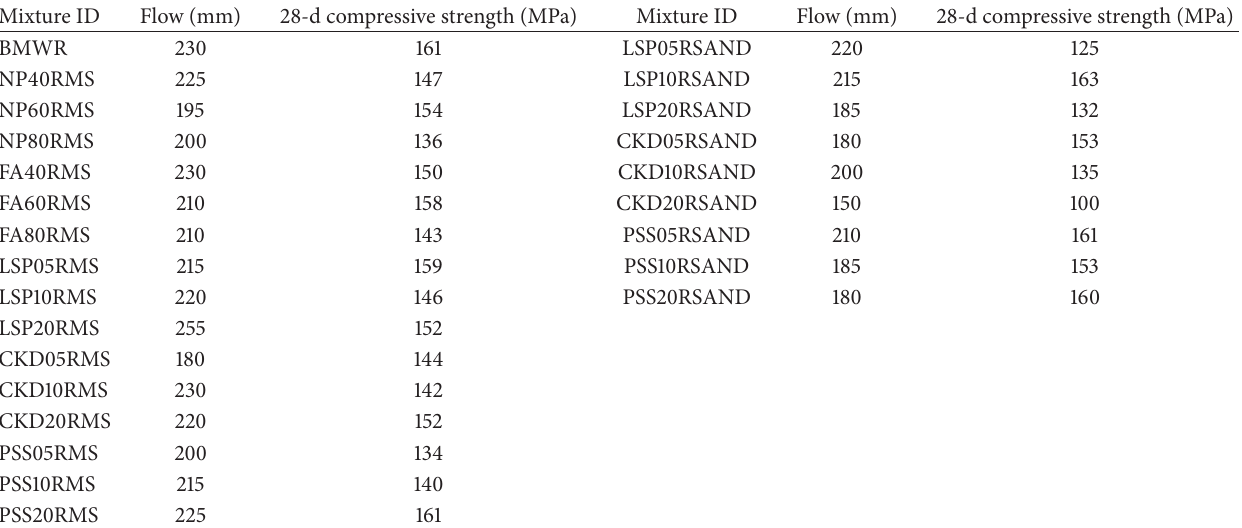
Table 8: Flow and compressive strength test